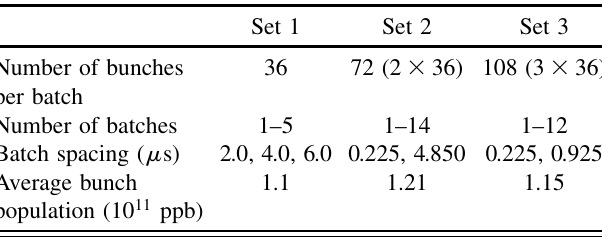
TABLE I. Parameters used in the simulations for the different sets of measurements with 50 ns bunch spacing. The value 0 : 225 (cid:3) s for the batch spacing in sets 2 and 3 refers to the space between two or three trains of 36 bunches injected simultaneously.